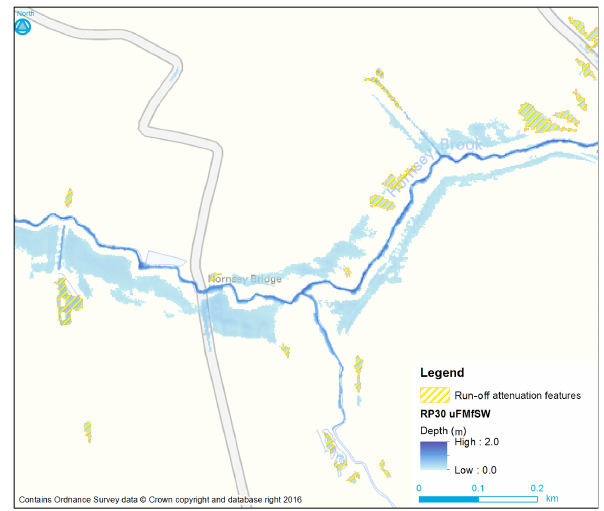
Figure 2. Hydrodynamic accumulation areas within Eden, identi- fied by JFLOW analysis for a designed storm of return period of 30 years (Hankin et al., 2017). Maximum water depths are indi- cated, and areas that exceed the threshold depth and other criteria (minimum area, slope angle and proximity to roads and buildings) are highlighted as potential sites for